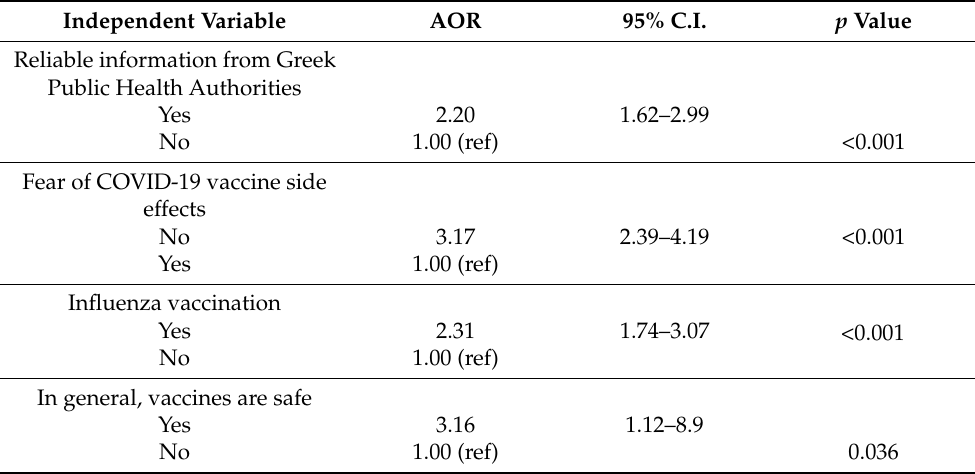
Table 4. Logistic regression analysis of COVID-19 vaccination